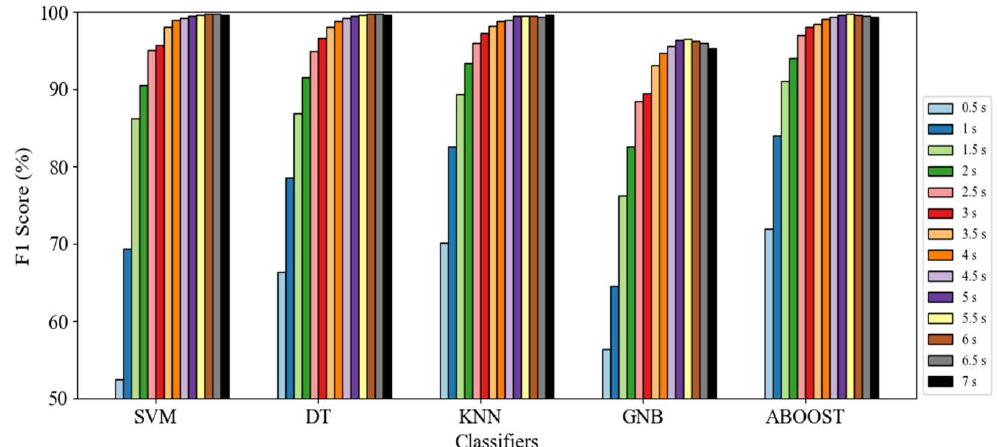
Figure 6. Average F1 score of motion mode classification using different machine-learning methods and window lengths.